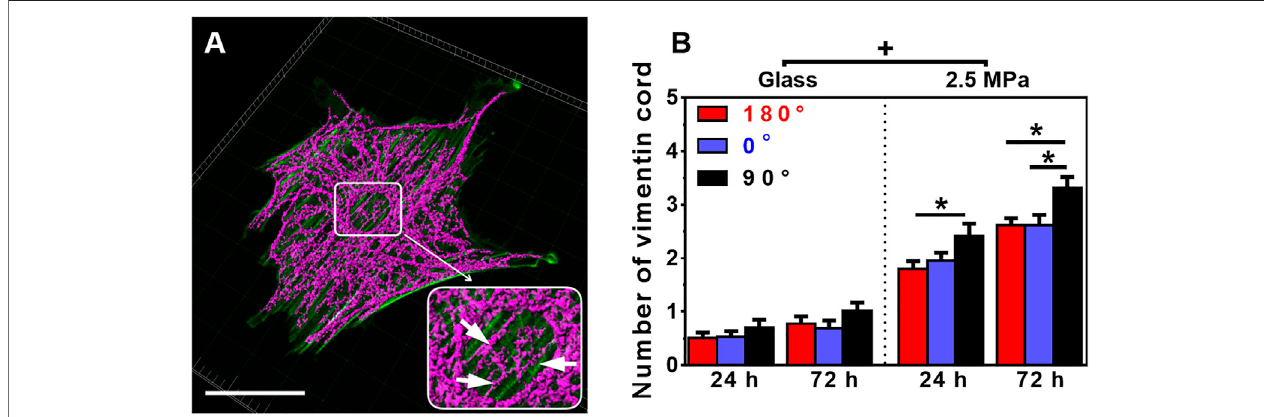
FIGURE 4 | Structure and number of vimentin cords. (A) Typical images of perinuclear vimentin cords (arrows in the insert) onto poly-dimethylsiloxane (PDMS) substrate (0 ° , 72 h). Bar = 50 µm. (B) The number of vimentin cords onto 2.5 MPa PDMS and glass, de fi ned previously (Zhang et al., 2017), was compared in three orientations. Data were presented as mean ± SE for 45 cells from three repeated experiments at 24 or 72 h. *, t -test, p < 0.05; + , three-way ANOVA test, p < 0.05.